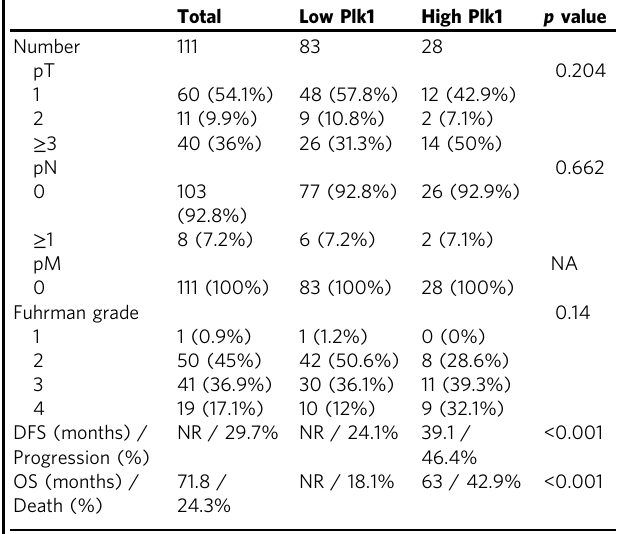
Table 1 The characteristics of the ccRCC M0 patients included in the